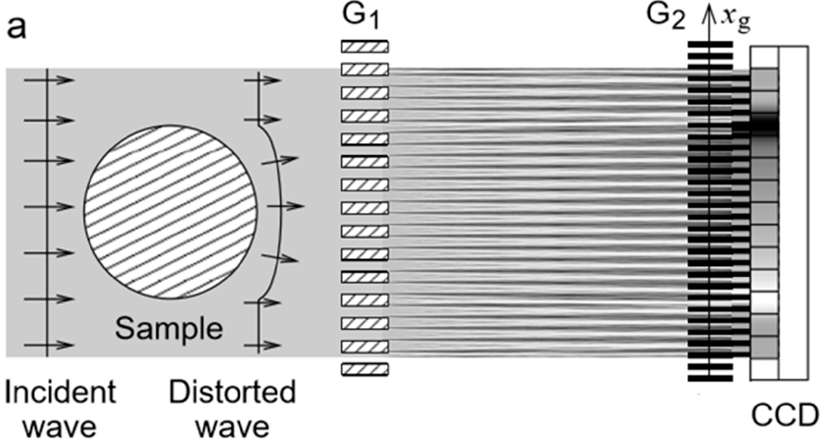
Figure 10. Sketch of the grating interferometer (Adapted with permission from [11], Copyright 2015 The Optical Society).